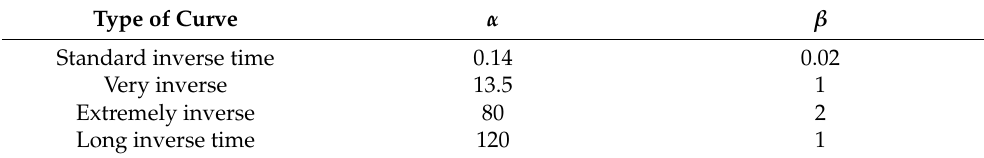
Table 1. Form constants for the exponential equation IEC